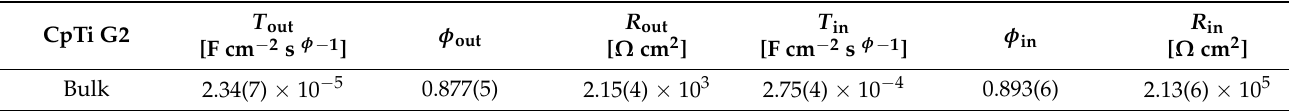
Table 5. The parameters with their standard deviations obtained using the equivalent electrical circuit model for corrosion shown in Figure 10d to approximate the experimental electrochemical impedance spectroscopy (EIS) data for the bulk CpTi G2 electrode in 0.1 M KOH solution saturated with O 2 at 25 ◦ C. R s was approximately equal to 11 Ω cm 2 . CpTi